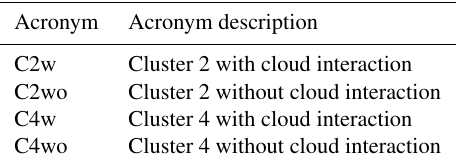
Table 1. Acronyms of the performed model